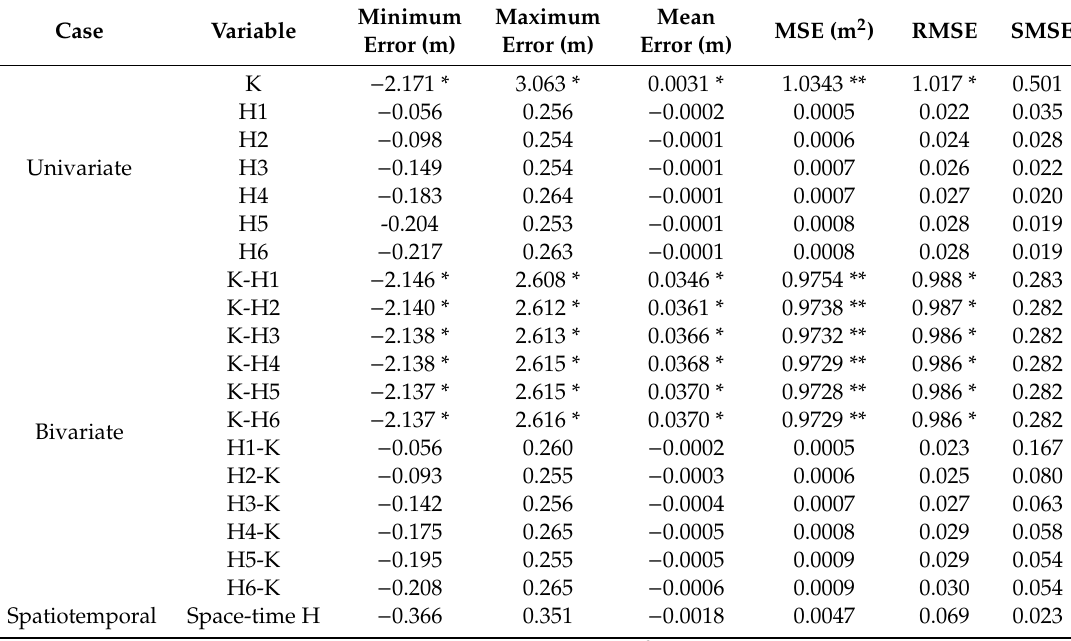
Table 6. Cross validation results for the fitted variogram